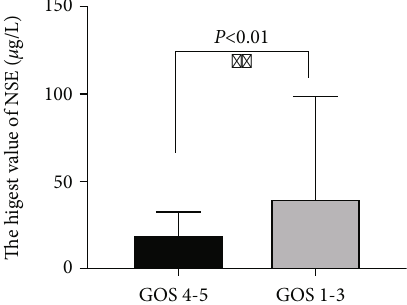
Figure 4: Maximum value of NSE was signi fi cantly di ff erent between two prognosis